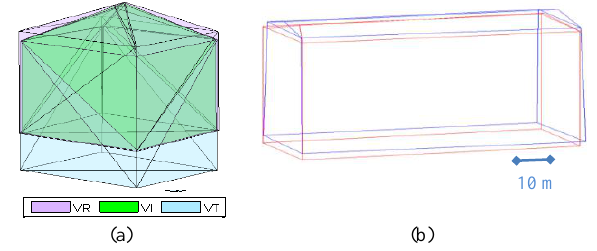
Figure 9. (a) Relationship between reference model ( VR ) and tested model ( VT ), with ; (b) superimposition of the reference model (in red) and the extracted model for the building No. 2 (in